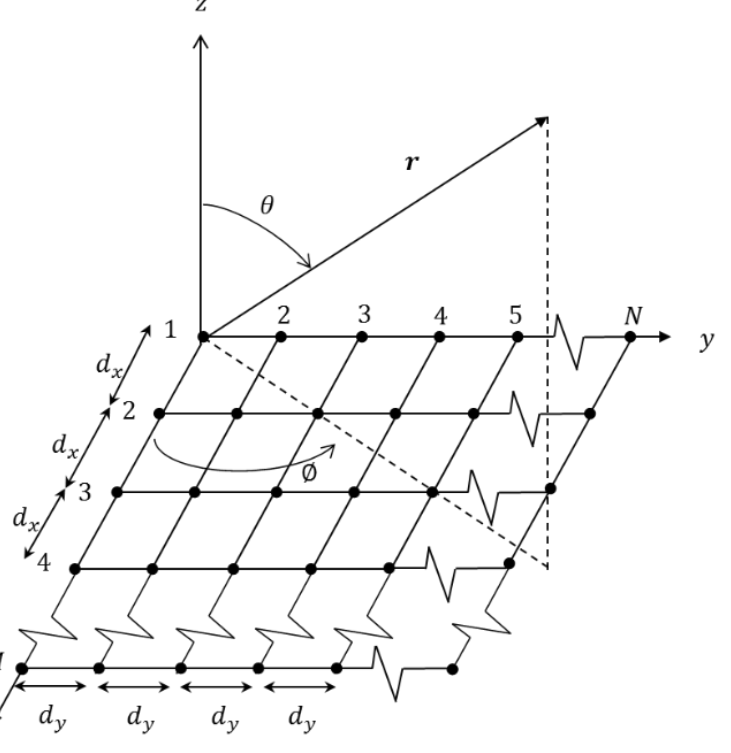
Figure 2. 𝑀 × 𝑁 elements in an array with uniform inter-element distance. Figure 2. M × N elements in an array with uniform inter-element